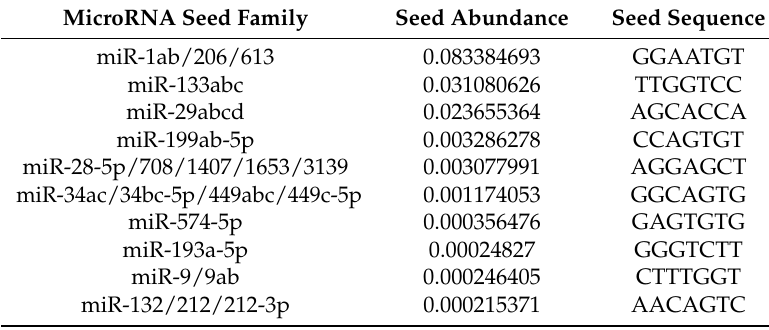
Table 3. MicroRNA seed families identified to bind to ANKRD1 mRNA transcript [96]. MicroRNA Seed Family Seed Abundance Seed